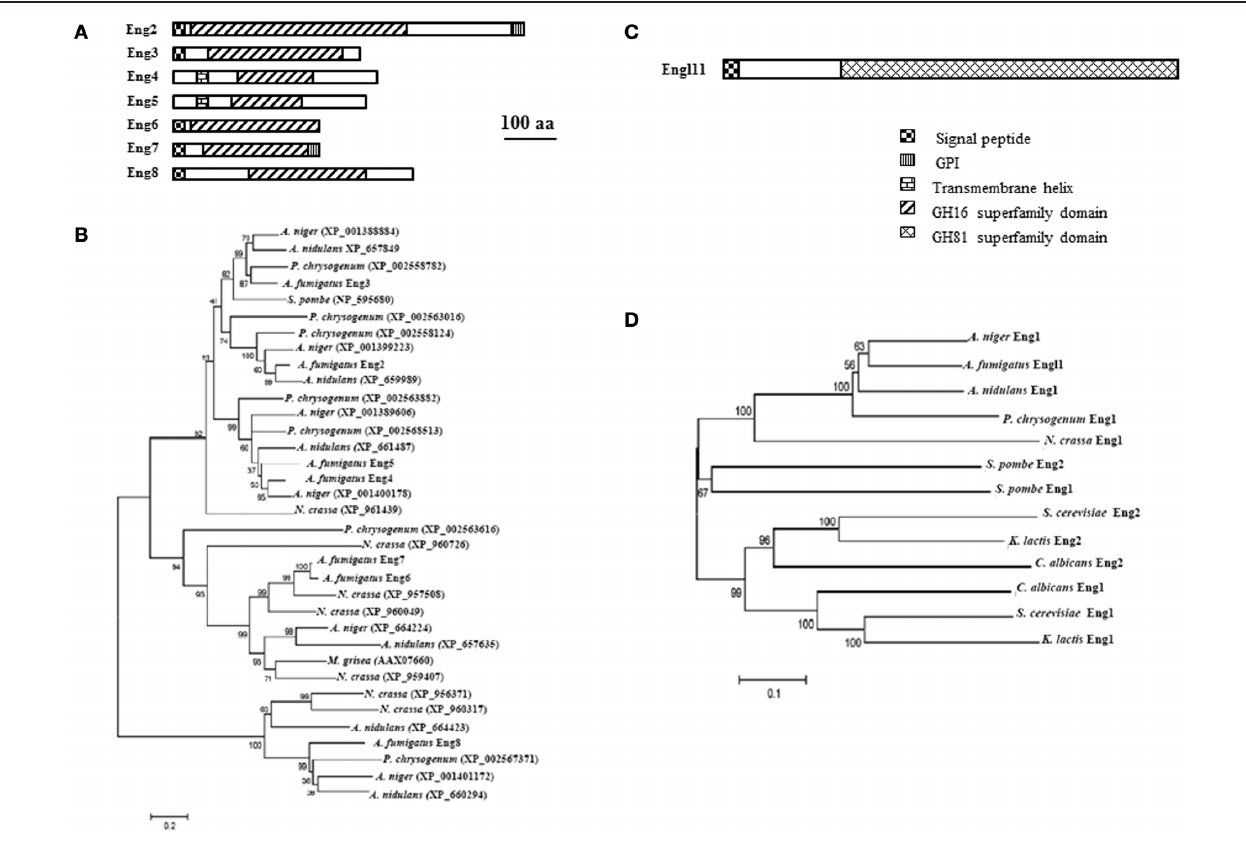
FIGURE 3 | Domain organization and phylogenetic tree of A. fumigatus endo- β -1,3-glucanases. Protein domains identified using SignalP 3.0, big-PI, TMHMM v. 2.0, and CD search (100 aa: protein length proportional to 100